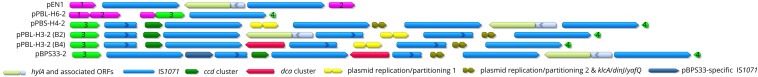
The synteny of the IS1071 insertion sites on various PromA γ plasmids. The bases between the IS1071 elements were deleted for simplicity and the IS1071-associated cargo was represented by single ORFs, functions of which are indicated in the legend. Broken arrows represent truncated IS1071 tnpA ORFs. The IS1071-flanking plasmid backbone genes are numbered 1–4: (1) repB (2) mobA (3) trbM (4) traS. Light green arrows represent conjugation-related genes, and purple arrows represent replication/partitioning genes.